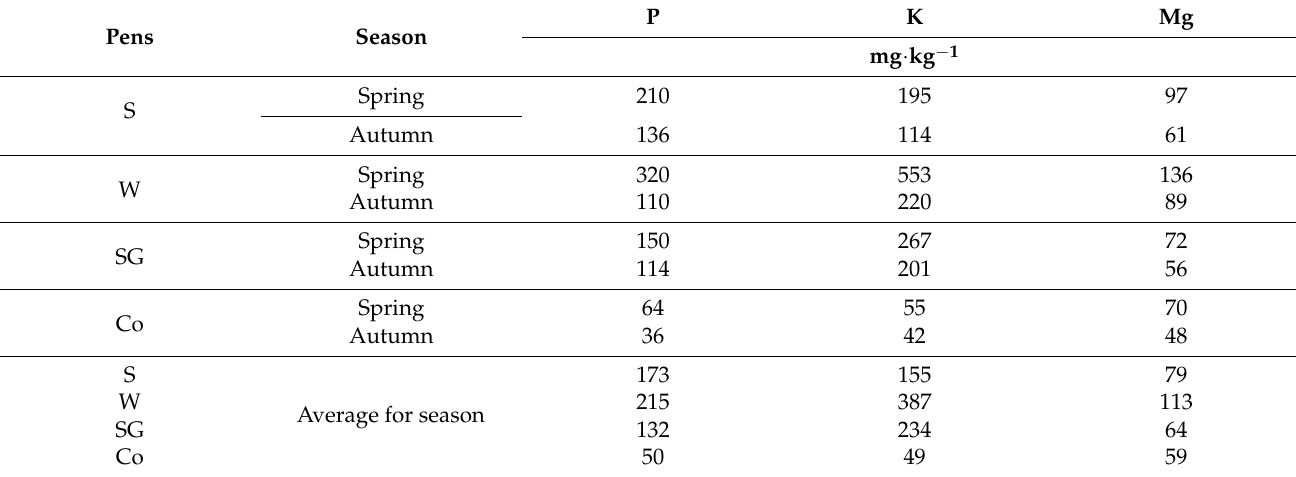
Table 4. The content of assimilable phosphorus (P), potassium (K) and magnesium (Mg) forms in the soil. Pens